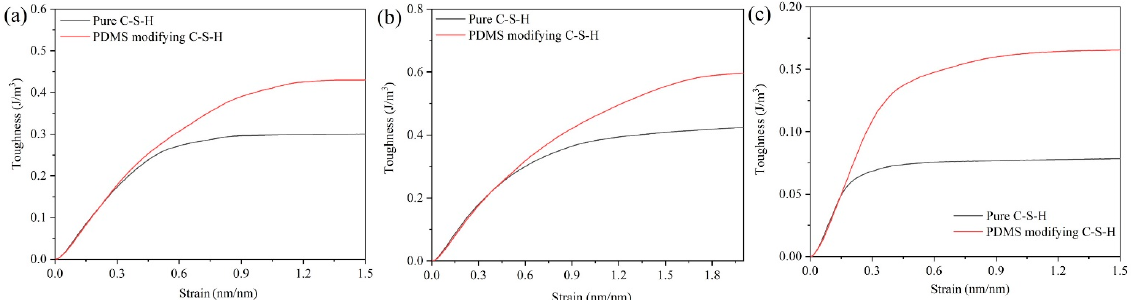
Figure 8. Volumetric energy of and C-S-H and PDMS-modified C-S-H along the ( a ) x -axis; ( b ) y - axis; ( c ) z -axis. ( c ) z